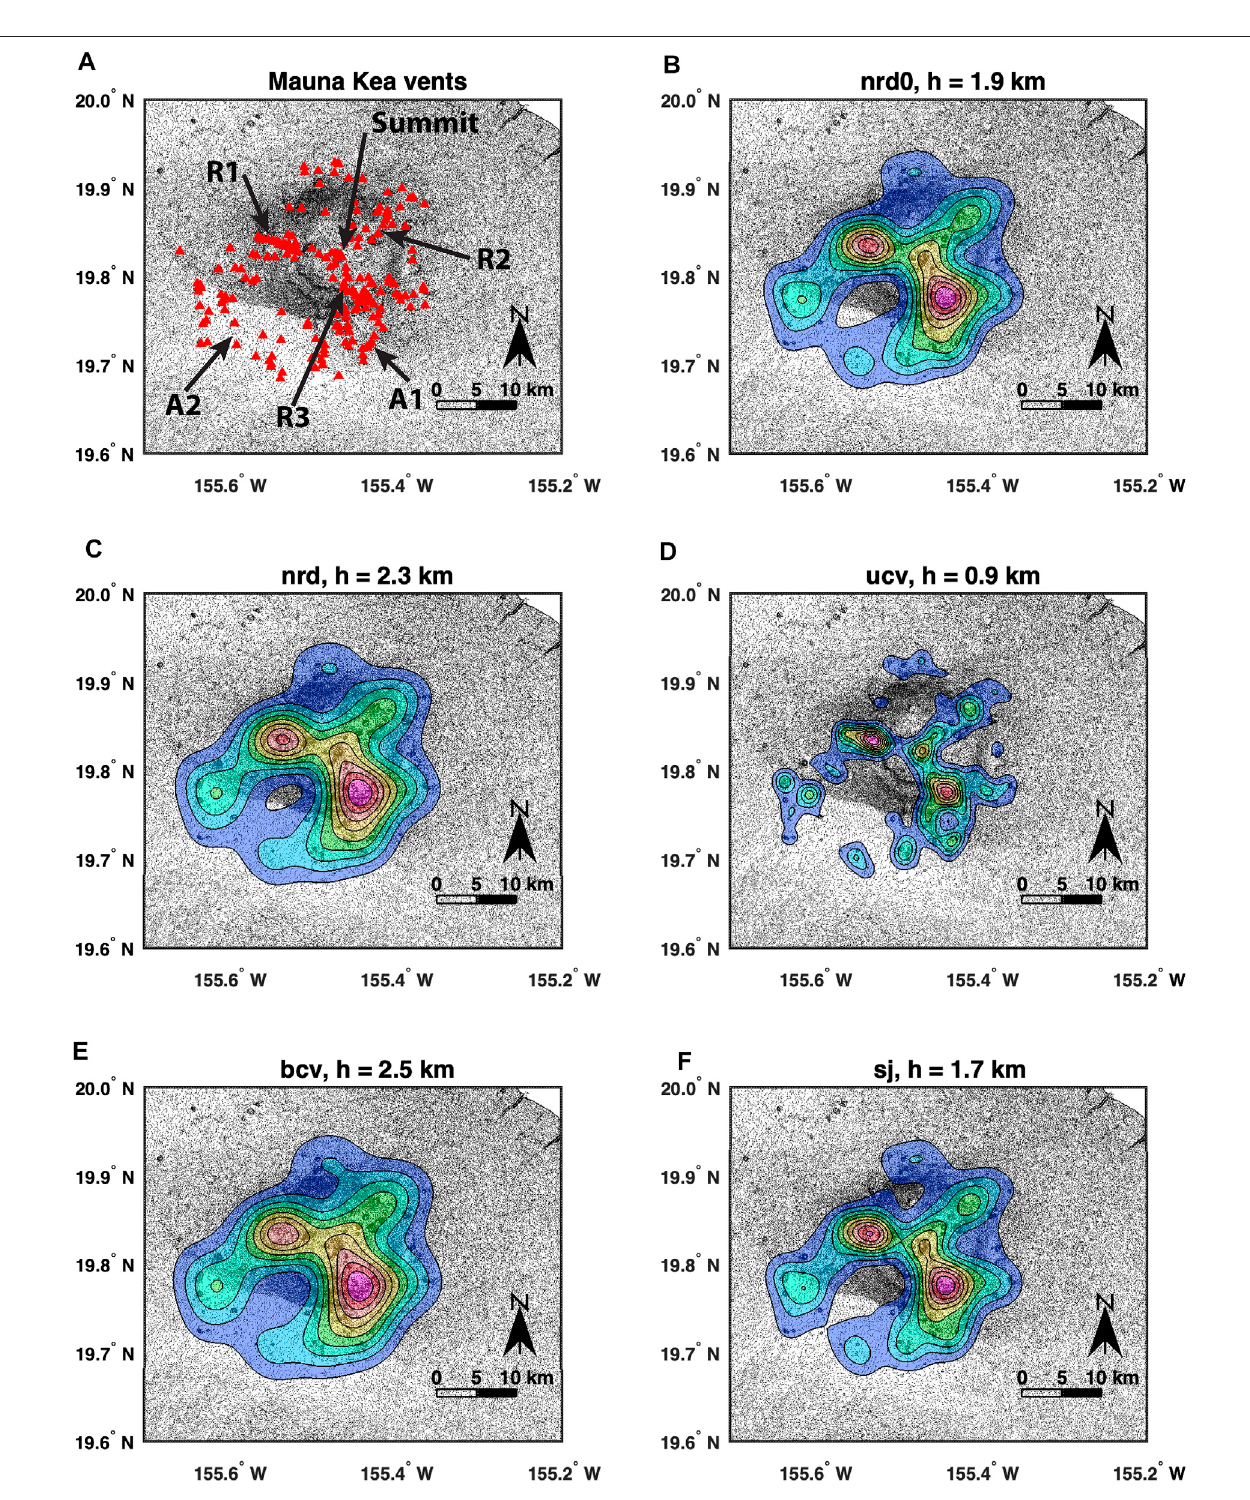
FIGURE3 | Estimated PDFs using the selector and corresponding bandwidth asindicated on top ofeach panel. The fi rst panel (A) shows the location ofthe vents used for the calculations. Mauna Kea example.